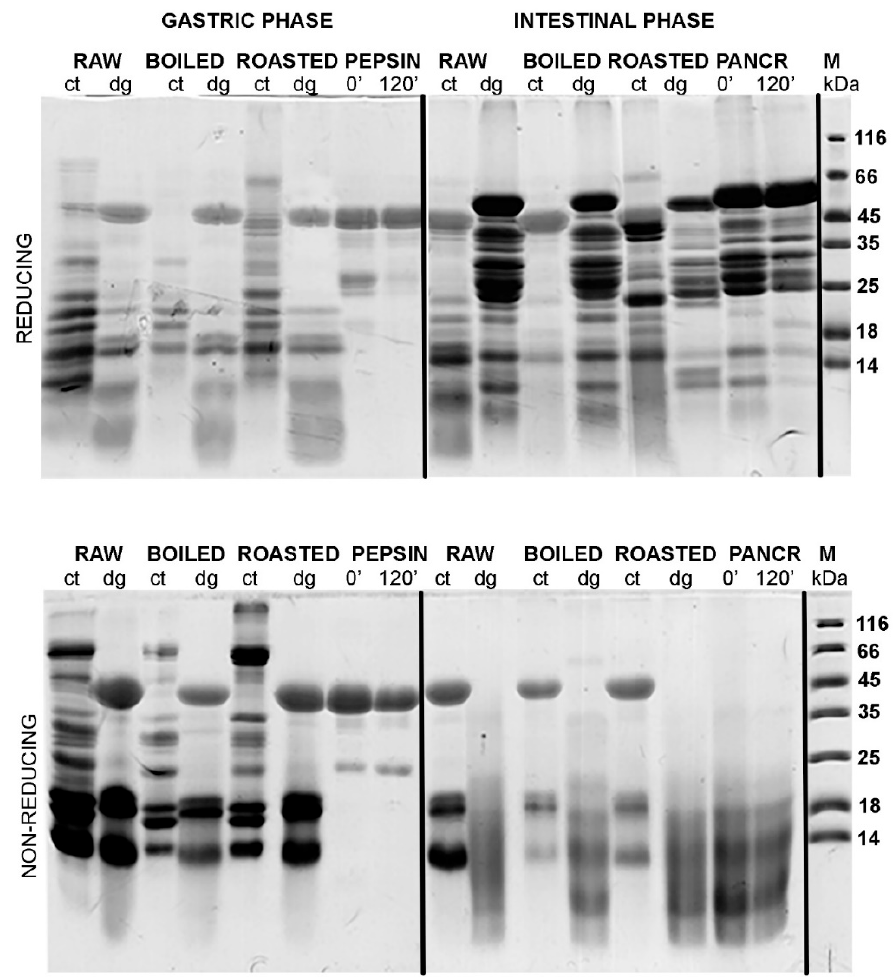
Figure 4. SDS-PAGE protein profiles of TCA / acetone defatting and protein precipitation of raw, boiled and roasted liquid peanut gastric and intestinal digests and their controls. SDS-PAGE was performed in reducing and non-reducing conditions on 14% gels. ct—control at 120 min; dg—digest at 120 min; PEPSIN—controls containing only pepsin at 0 and 120 min; PANCR—controls containing only pancreatin at 0 and 120 min; M—molecular weight markers.